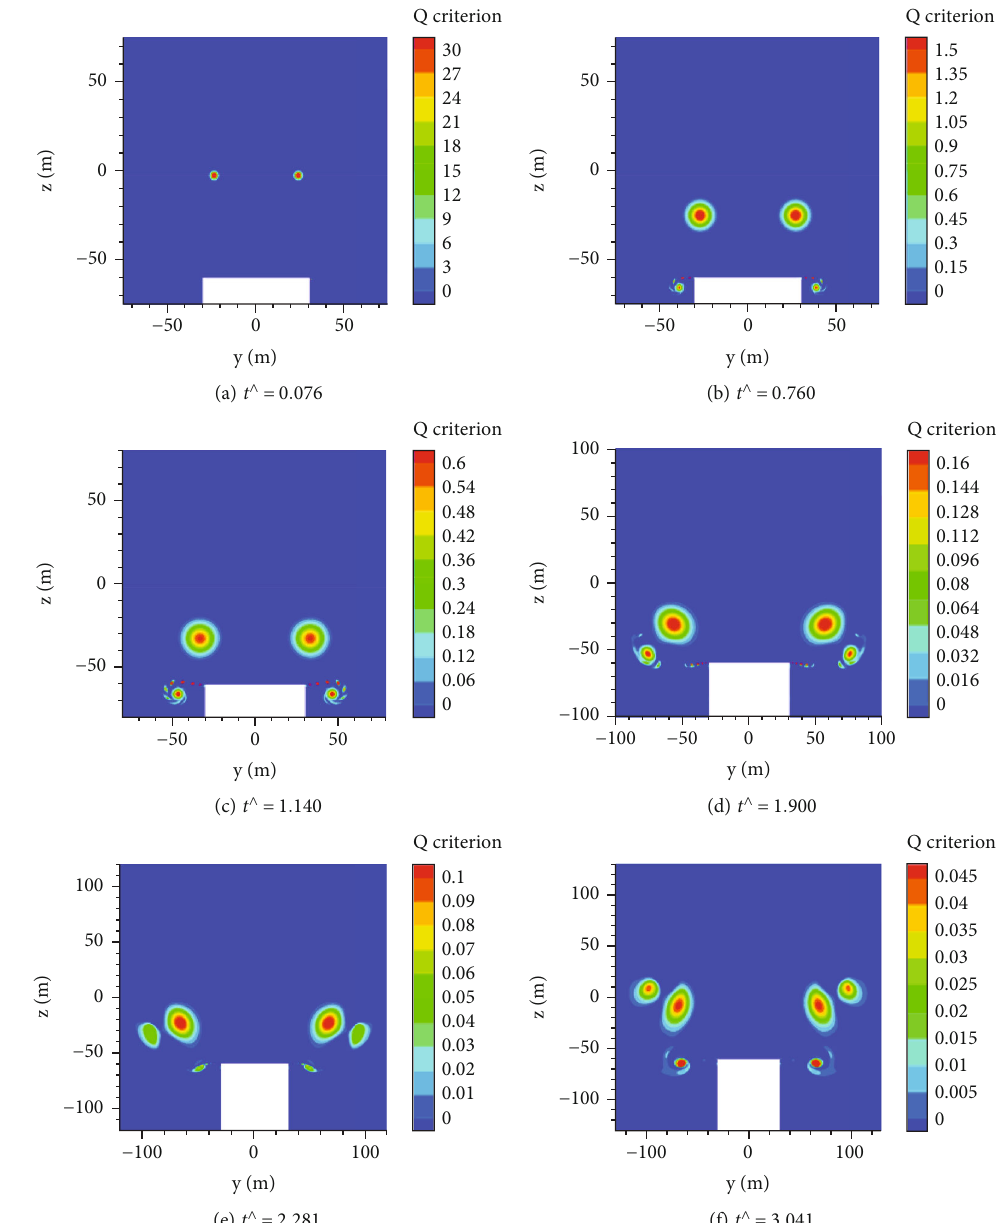
Figure 17: Contours of Q criterion at di ff erent times when the wake is 60 m above the